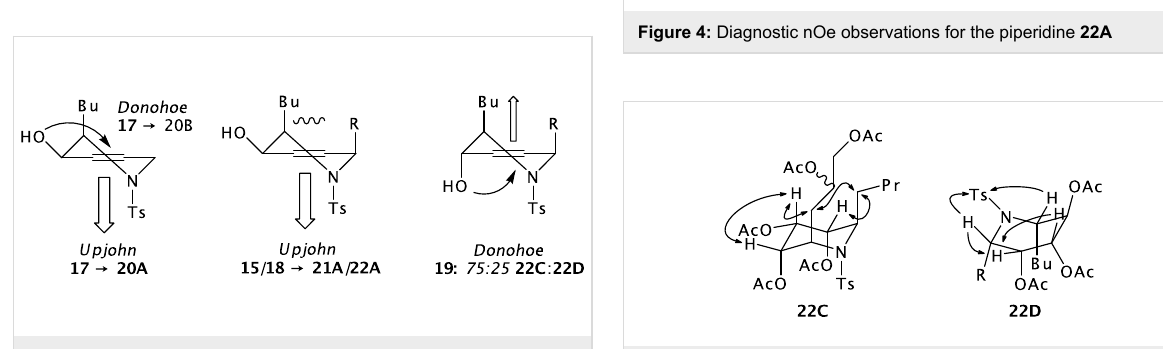
Figure 5: Diagnostic nOe observations for the piperidines 22C and 22D